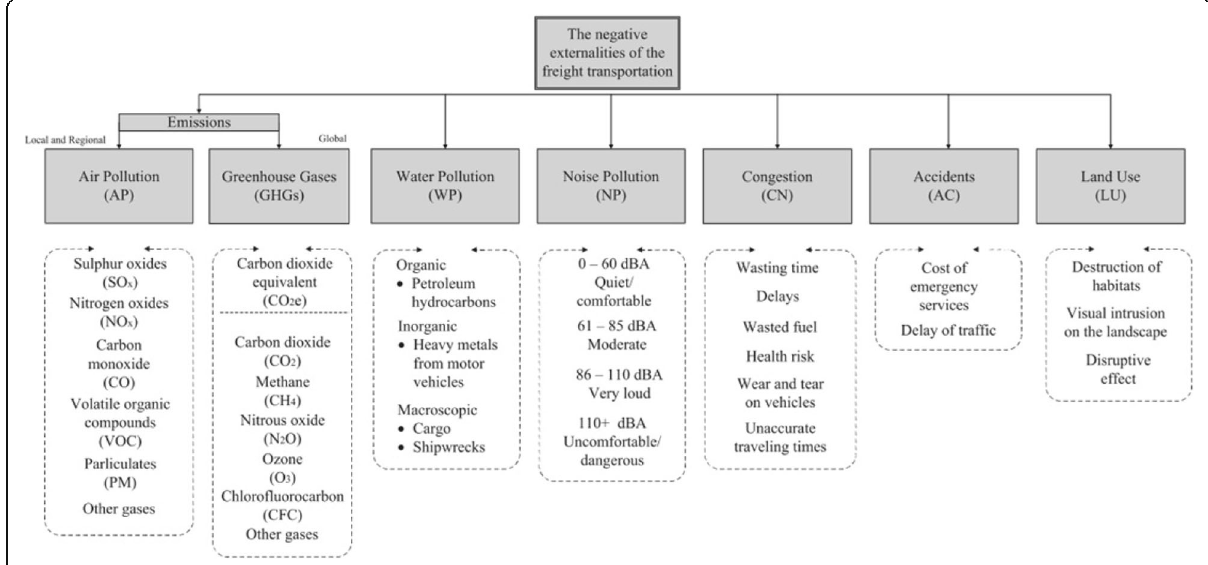
Fig. 5 The classification of some negative externalities of freight transport [5]